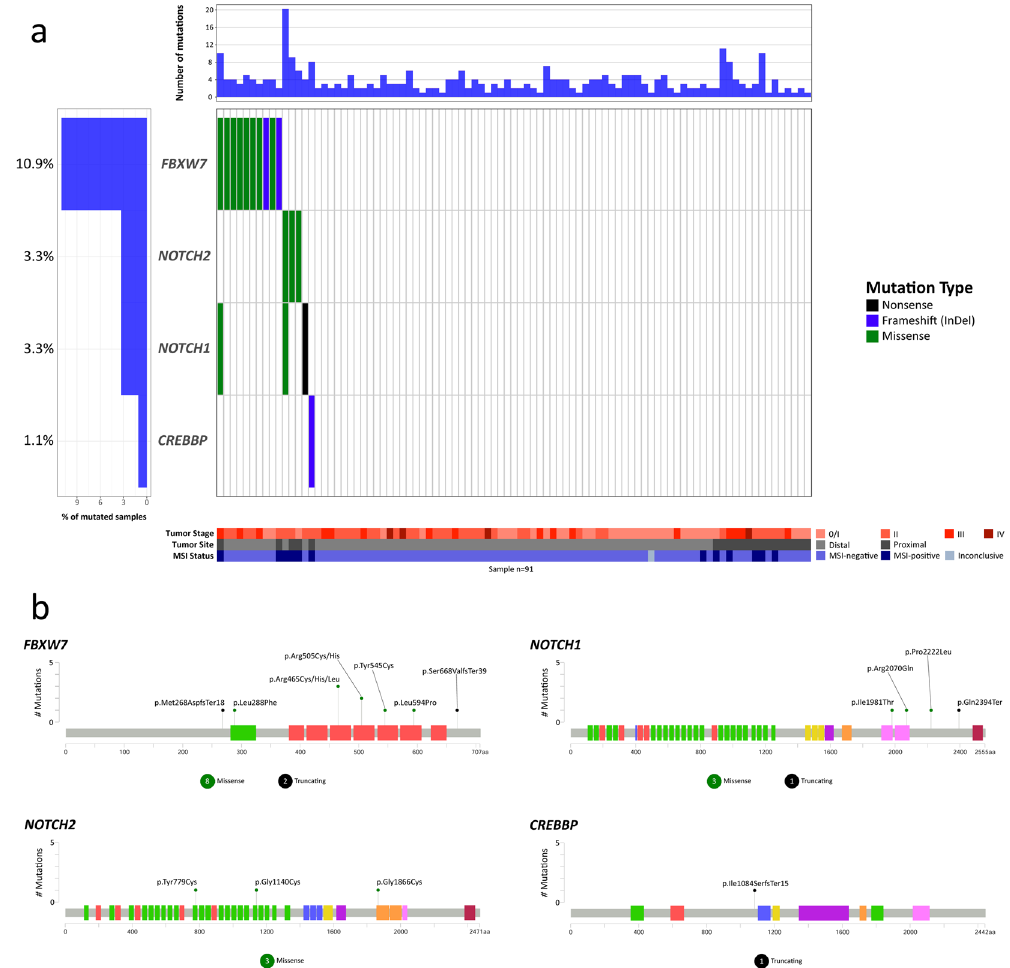
Figure 4. Waterfall (oncoplot) plot ( a ) and mutation mapper ( b ) of Notch signaling pathway genes. Tumor stage: stage of the disease at diagnosis. MSI: microsatellite